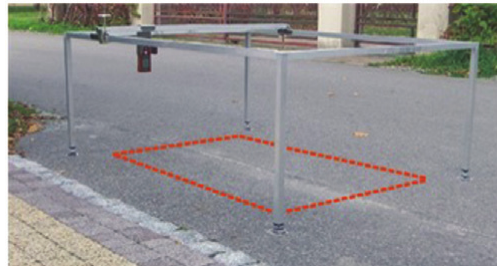
Fig. 7. Researched surface of road pavement